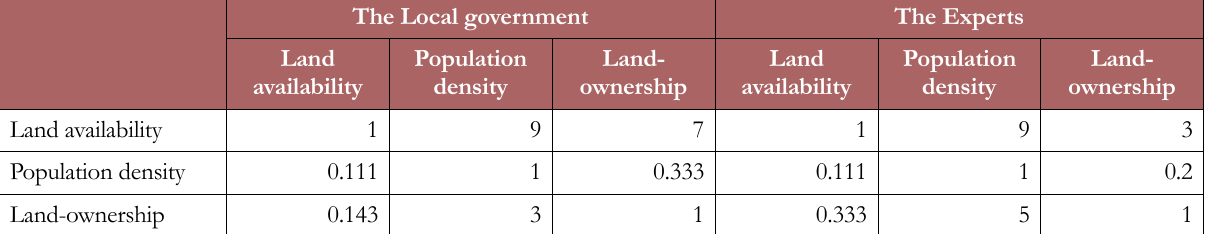
Table 2. Pairwise comparison